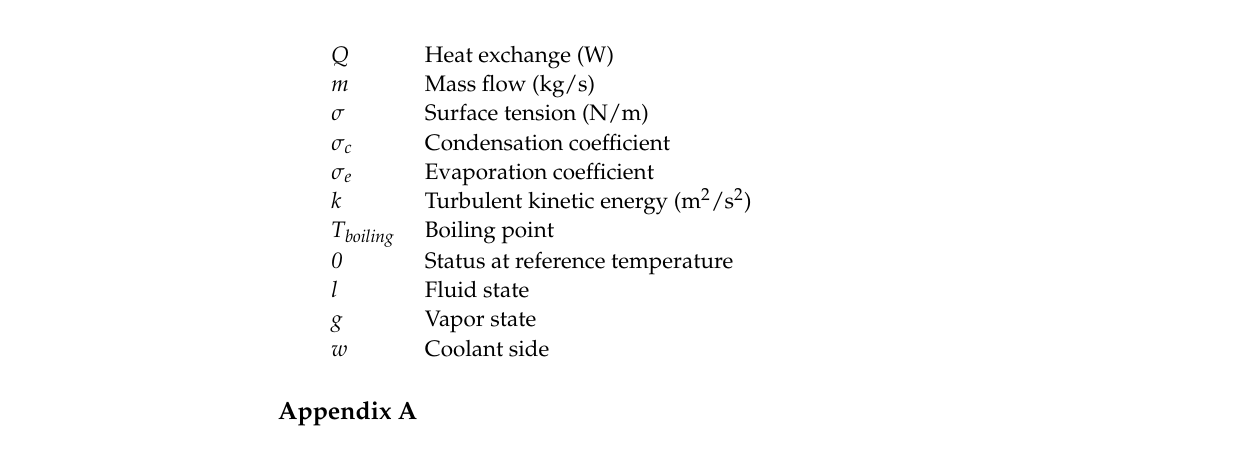
Table A1. The thermal properties of Novec 7100.